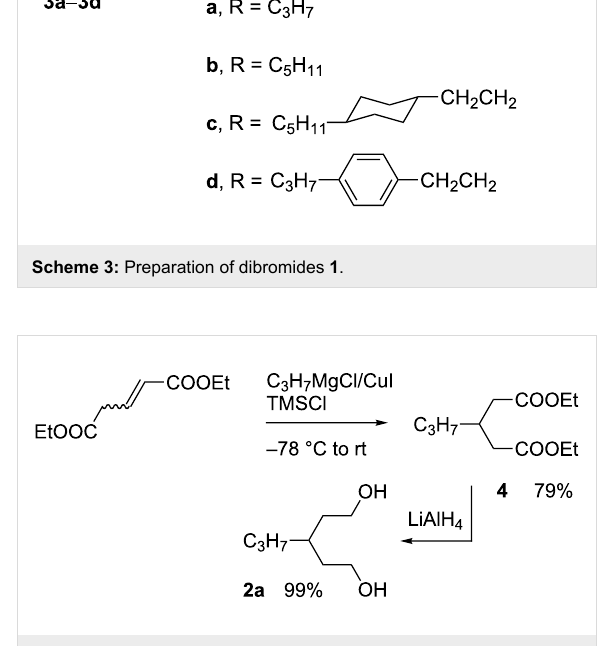
Scheme 4: Preparation of diol 2a